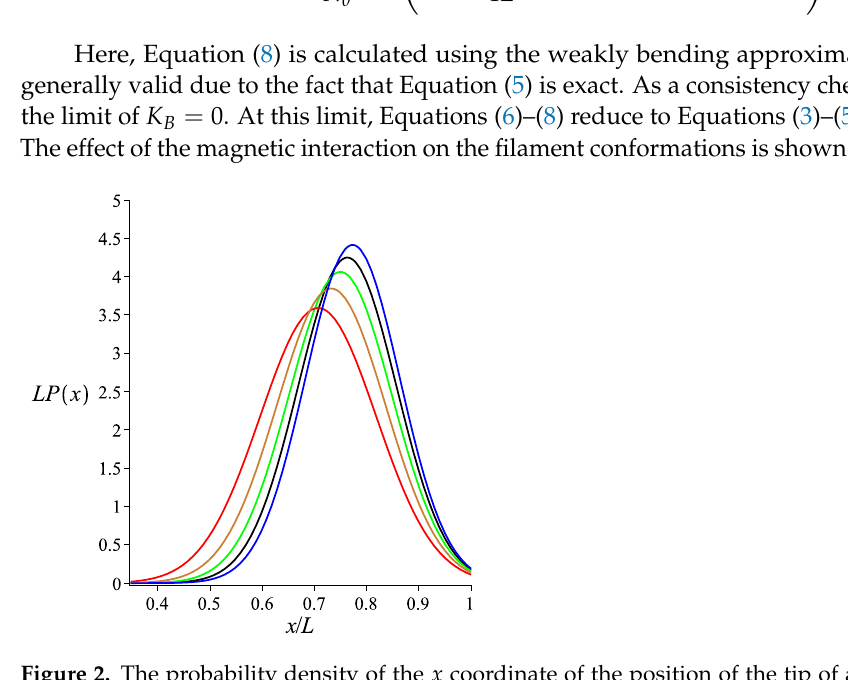
Figure 2. The probability density of the x coordinate of the position of the tip of a single grafted filament with a magnetic bead, as shown by Equation (6). The red, gold, green, black and blue colours correspond to K B = 0, K B = 3, K B = 6, K B = 9 and K B = 12, respectively. The fixed parameters for all curves are: L = 1 µ m; l p = 27 µ m; ω = π ; θ B = π ; and θ µ = 0. 8 4